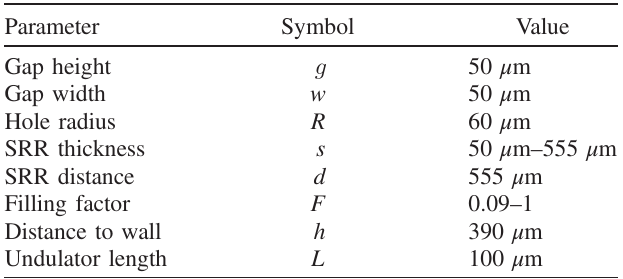
TABLE I. SRR undulator dimensions (see also Fig. 1 for the definition of